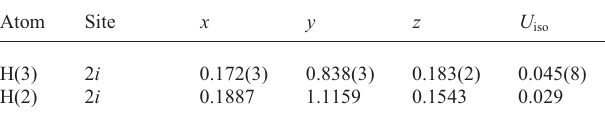
Table 2. Atomic coordinates and displacement parameters (in Å 2 )